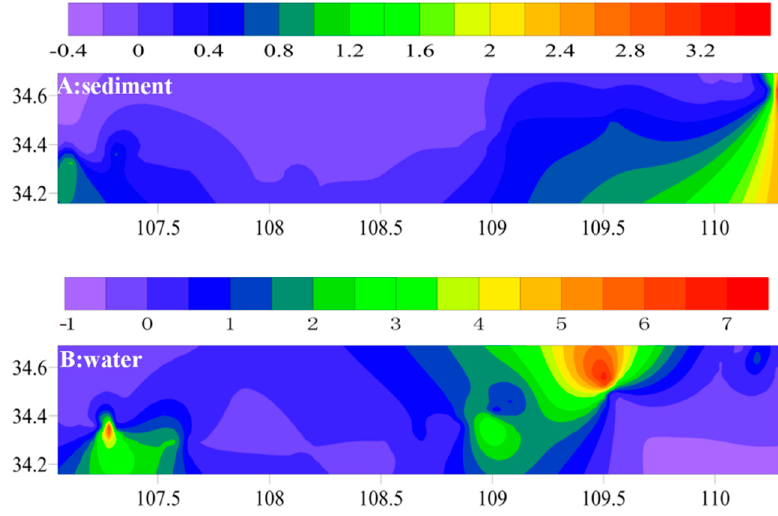
Figure 2. Spatial distribution of TBBPA in sediment ( A ) and water ( B ).